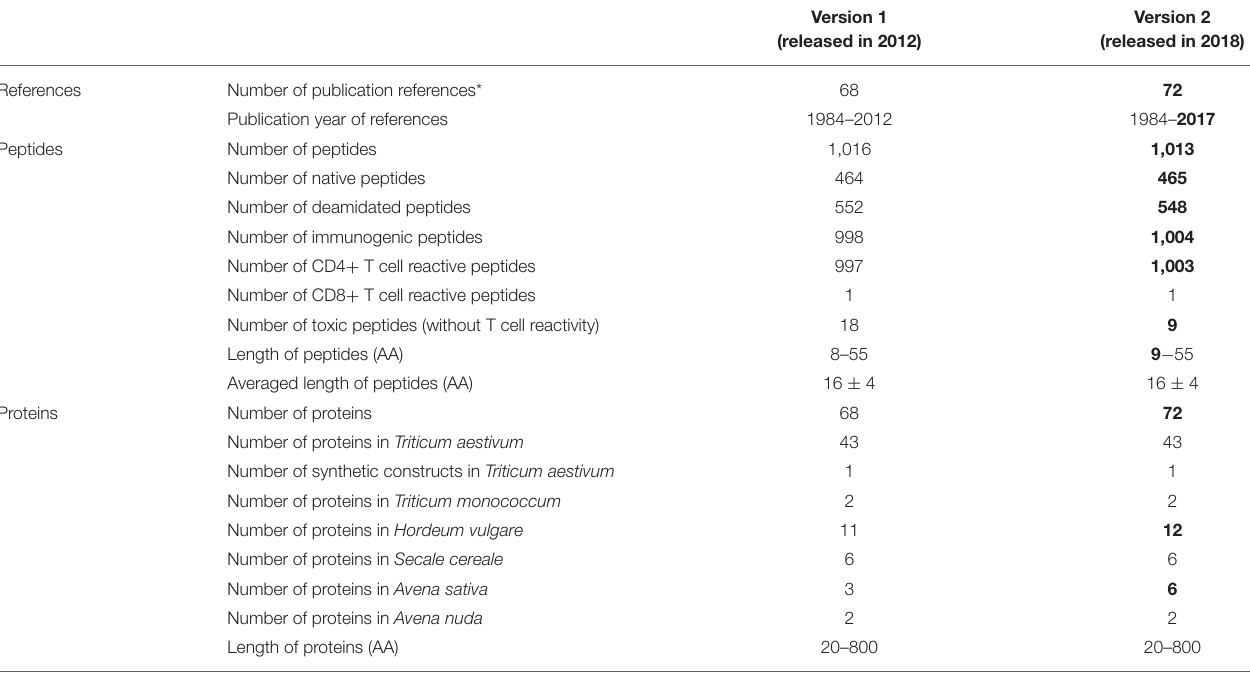
TABLE 1 | Statistics of the AllergenOnline.org CeD peptide and protein database version construction and inclusion